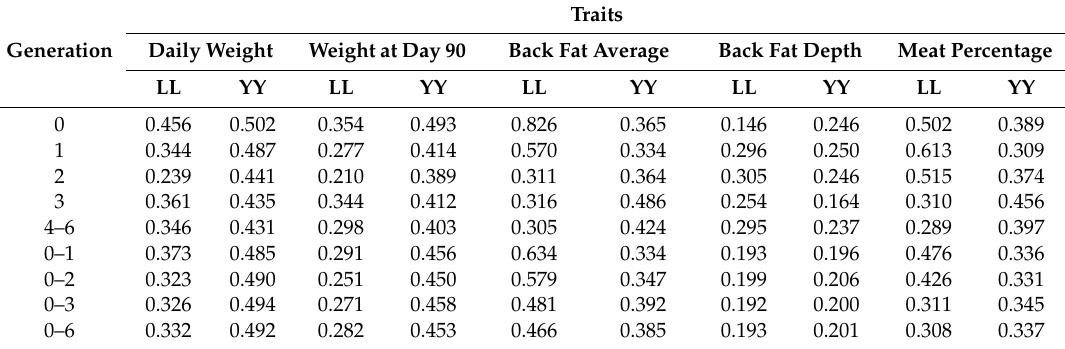
Table 2. Heritabilities of the five traits for di ff erent generations in reference populations, by breed (LL and